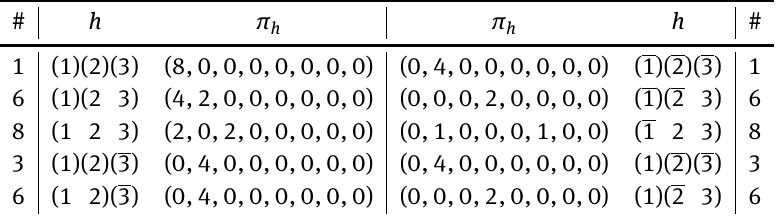
Table 3: Cycle types of induced permutations and their cardinality.